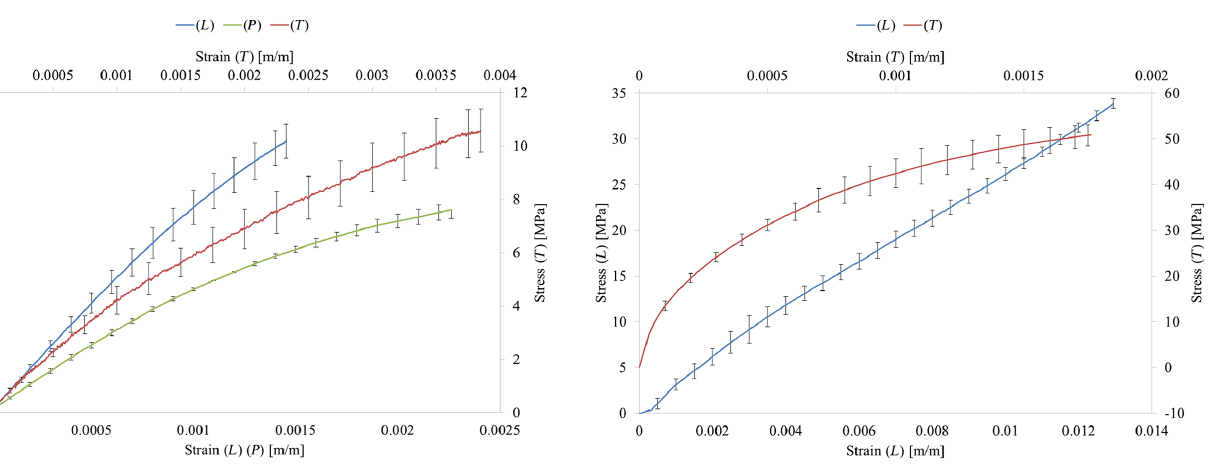
FIG. 19. Plot of compressive stress against strain for MoGr. Longitudinal data and relevant axes marked with ( L ). Transverse data and relevant axes marked with ( T ).